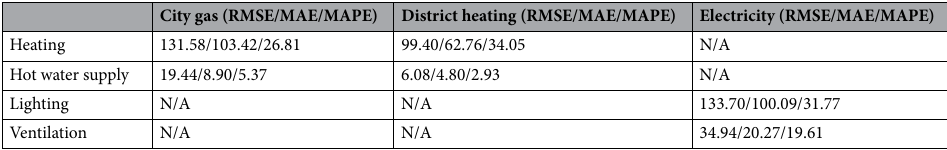
Table 3. Statistical performance of GWP assessment standard model. N/A not available, RMSE root mean squared error, MAE mean absolute error, MAPE mean absolute percentage error (%).